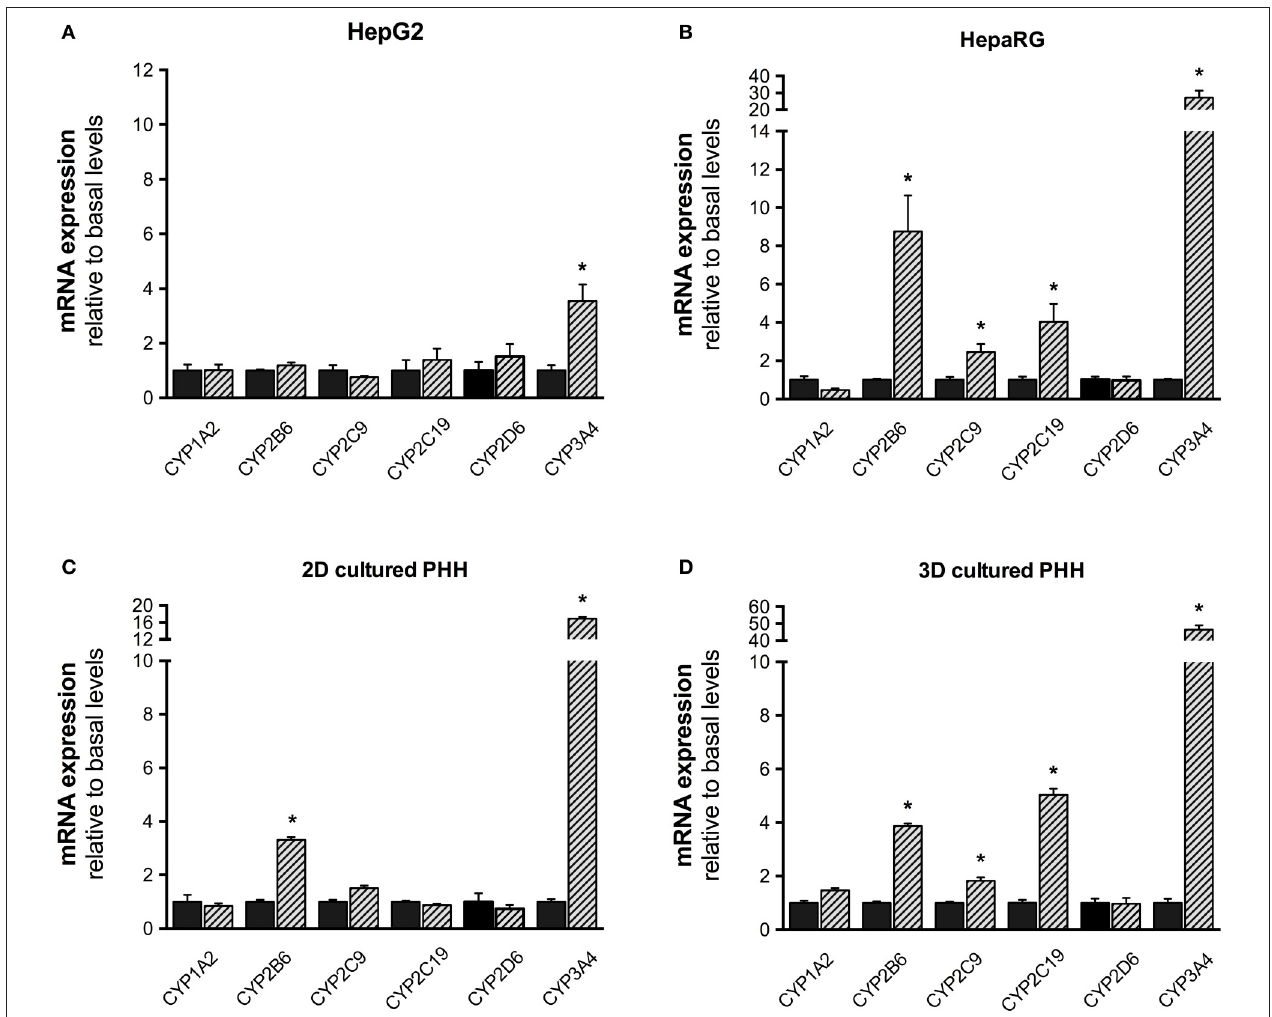
FIGURE 3 | mRNA expression of CYP1A2, 2B6, 2C9, 2C19, 2D6, and 3A4 in HepG2 (A) , HepaRG (B) , 2D- (C) , and 3D-cultured primary cryopreserved human hepatocytes (D) after treatment with 20 µ M rifampicin for 48 h. mRNA expression was determined by rt-PCR as described in the Materials and Methods Section. Values were normalized to GAPDH expression. Results are expressed as the mean ± SEM fold increase after treatment with rifampicin relative to levels observed in control cultures. PHH, primary human hepatocytes. * p < 0.05 vs. control